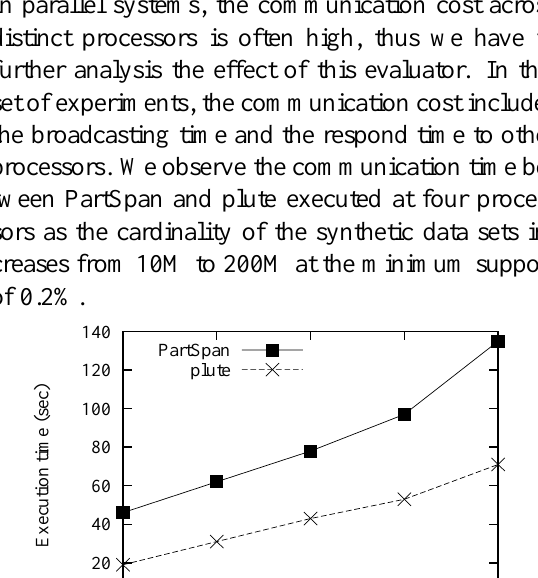
Fig. 9. (Communication time comparison: synthetic